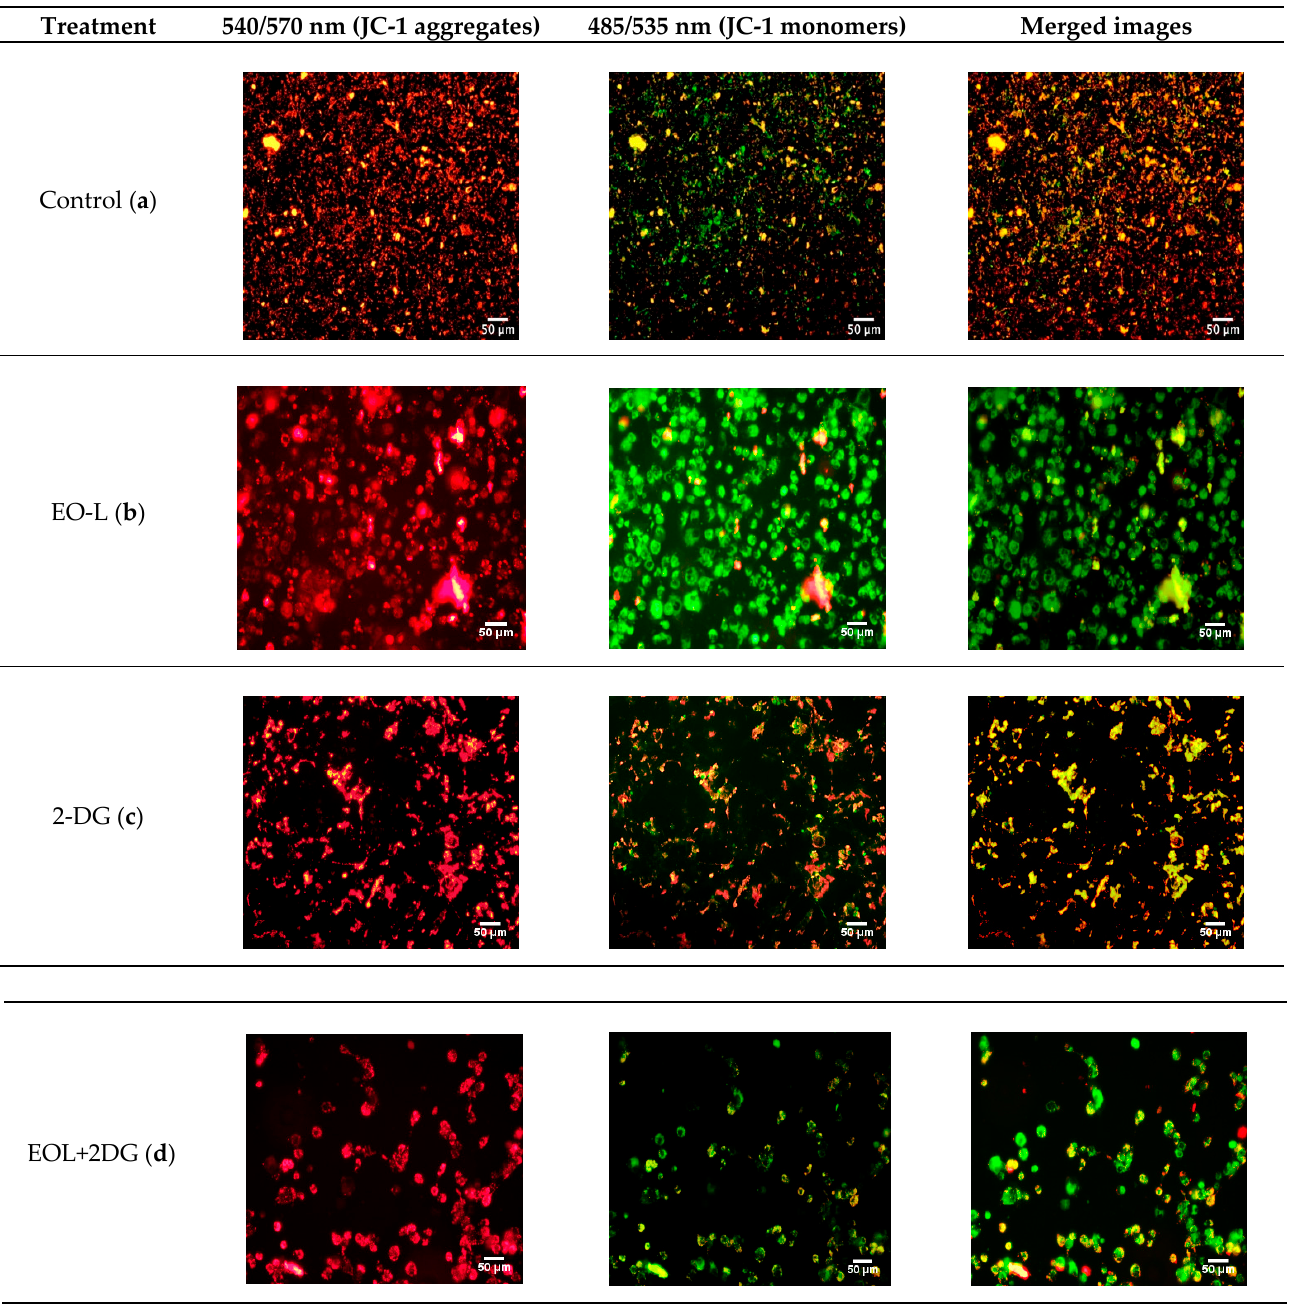
Figure 8. Fluorescence microscopy images of PANC-1 cells stained with JC-1 dye. Green fluorescence—depolarized (monomer) mitochondria; red fluorescence—(J-aggregates) mitochondria. PANC-1 cells were treated with ( a ) culture medium, ( b ) EO-L, ( c ) 2-DG and ( d ) EOL+2DG for 24